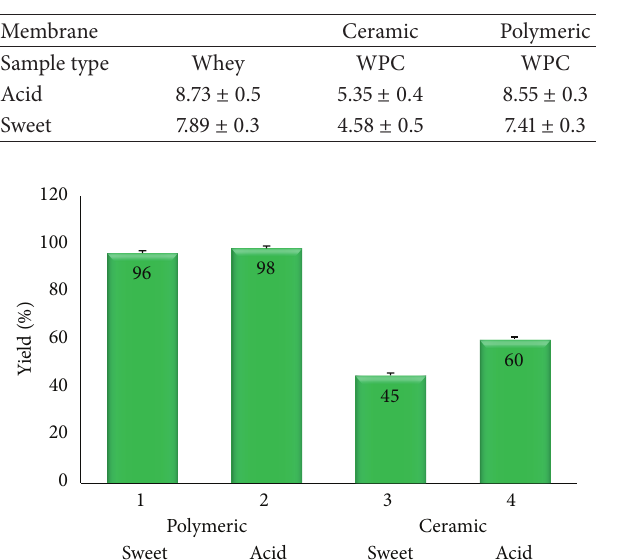
Figure 1: Percentage of yield in WPC by UF processes of sweet and acid whey with polymeric and ceramic membrane.